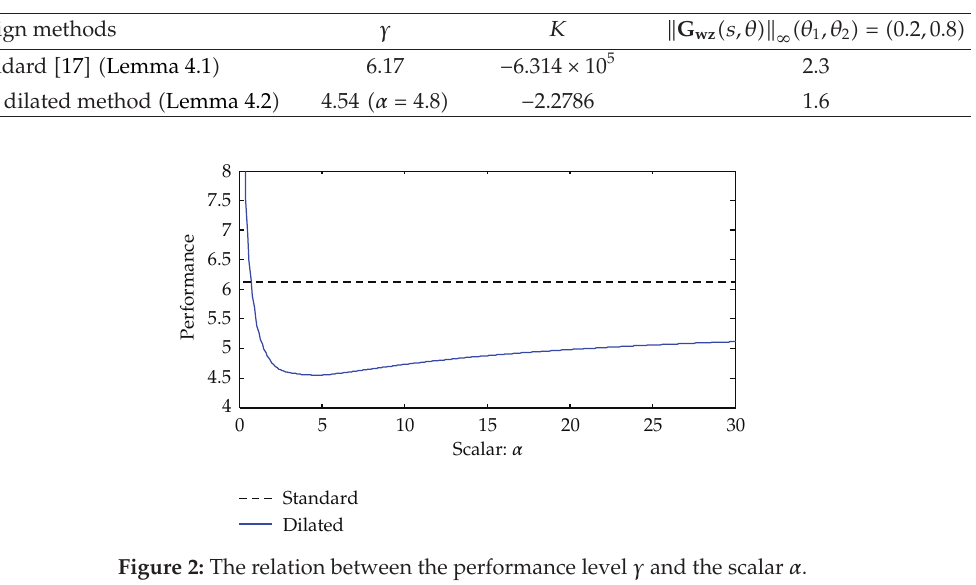
Table 2: Controller gain and the optimal H ∞ guaranteed cost.